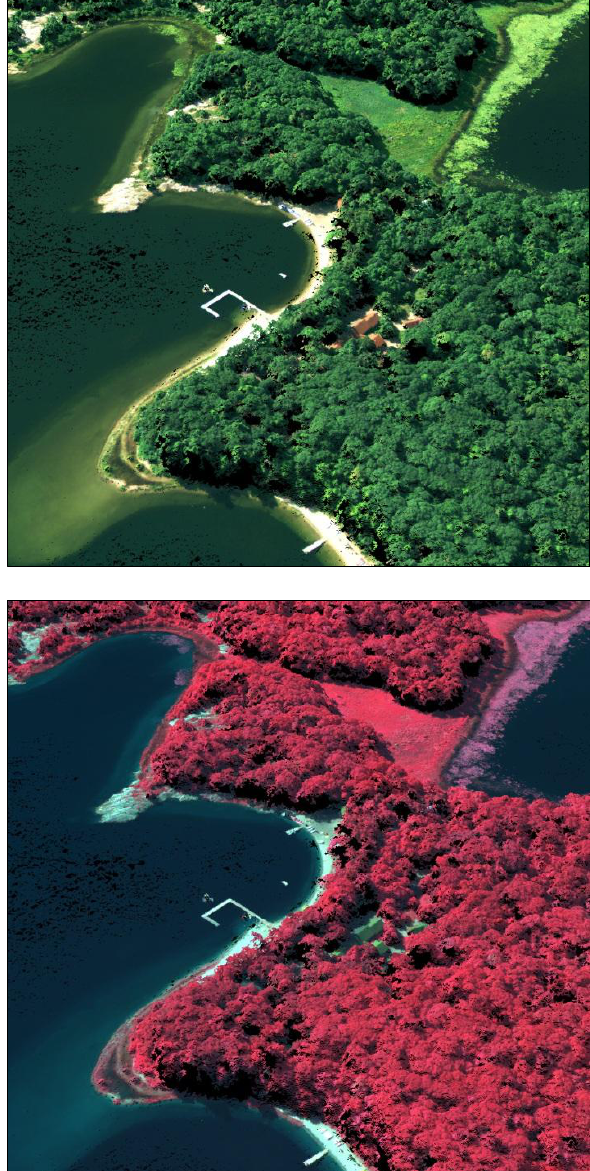
Figure 8: Comparison of RGB (top) and FCIR (bottom) info clouds in a forest area in Georgian Bay,